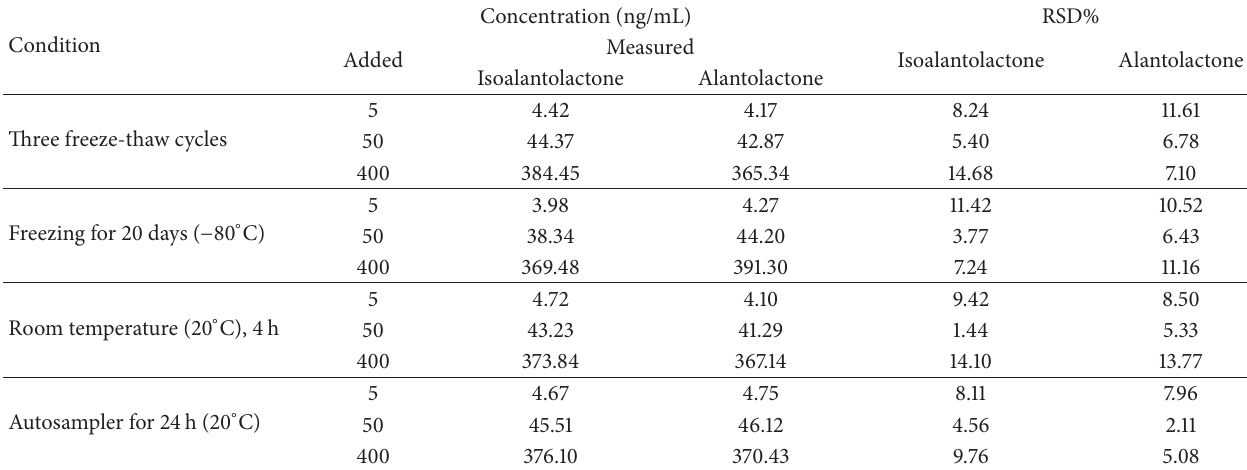
Table 3: Stability of samples under different storage conditions ( 𝑛 = 6 ).